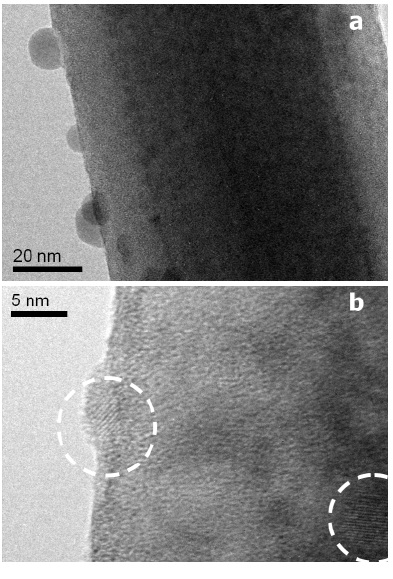
Figure 10. InP:Zn nanowires covered at 400 °C with ( a ) amorphous droplets and ( b ) crystalline droplets of a Zn-rich shell